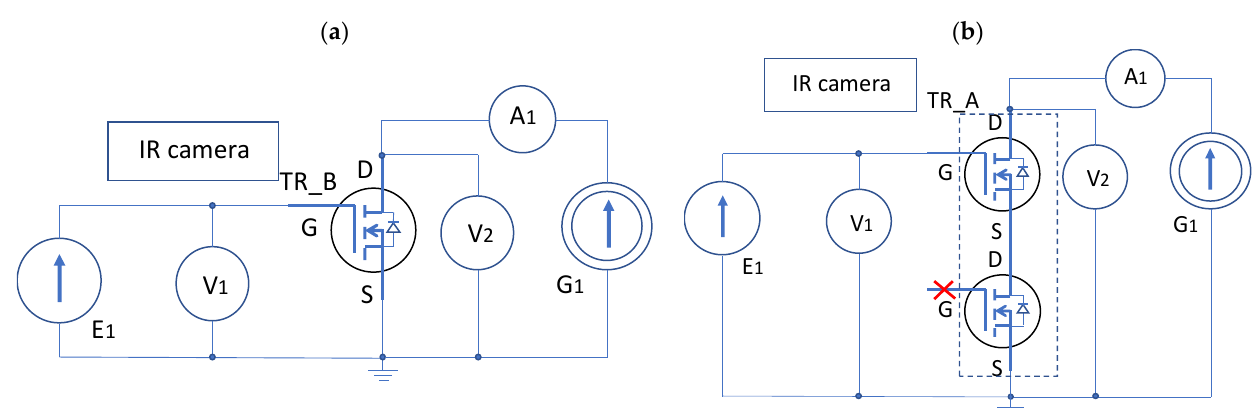
Figure 7. Set-ups for measuring thermal parameters of the BLC9G22LS-160VT transistor ( a ) and the BLC10G22LS-240PVT transistor ( b ).